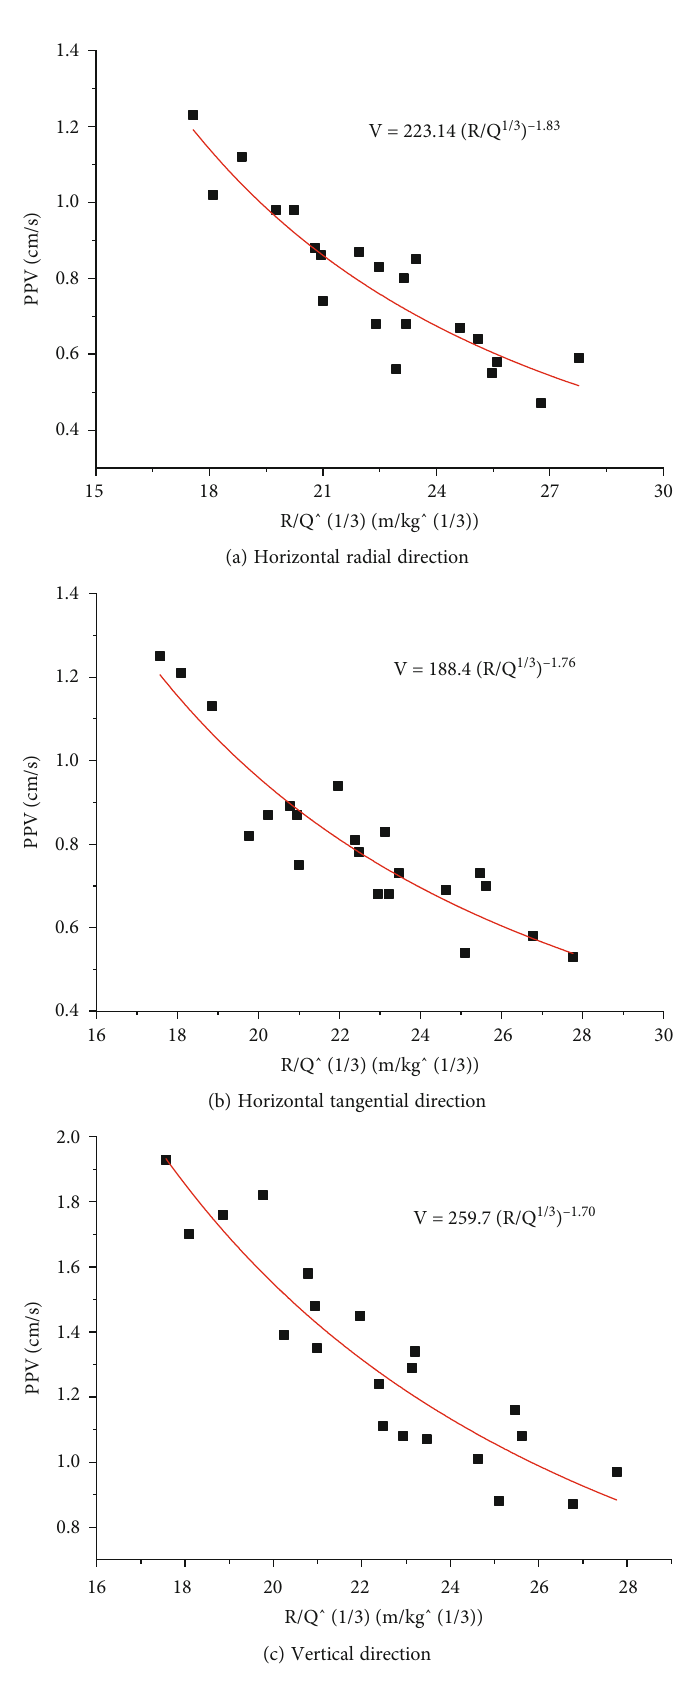
Figure 4: Vibration fi tting curve of Cut hole blasting fl